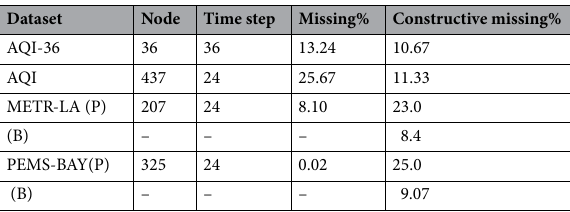
Table 1. Details relating to the